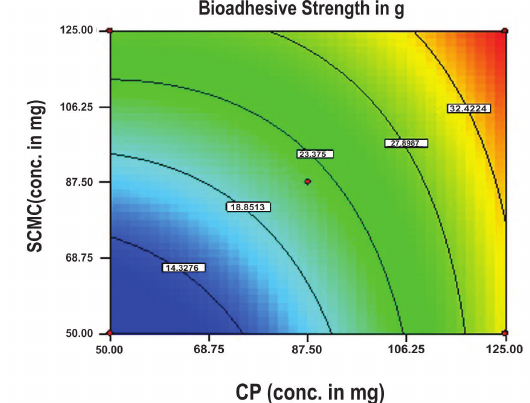
FIGURE 11 - Contour diagrams showing the influence of CP and SCMC on the value of bioadhesive strength of mucoadhesive tablet formulations of